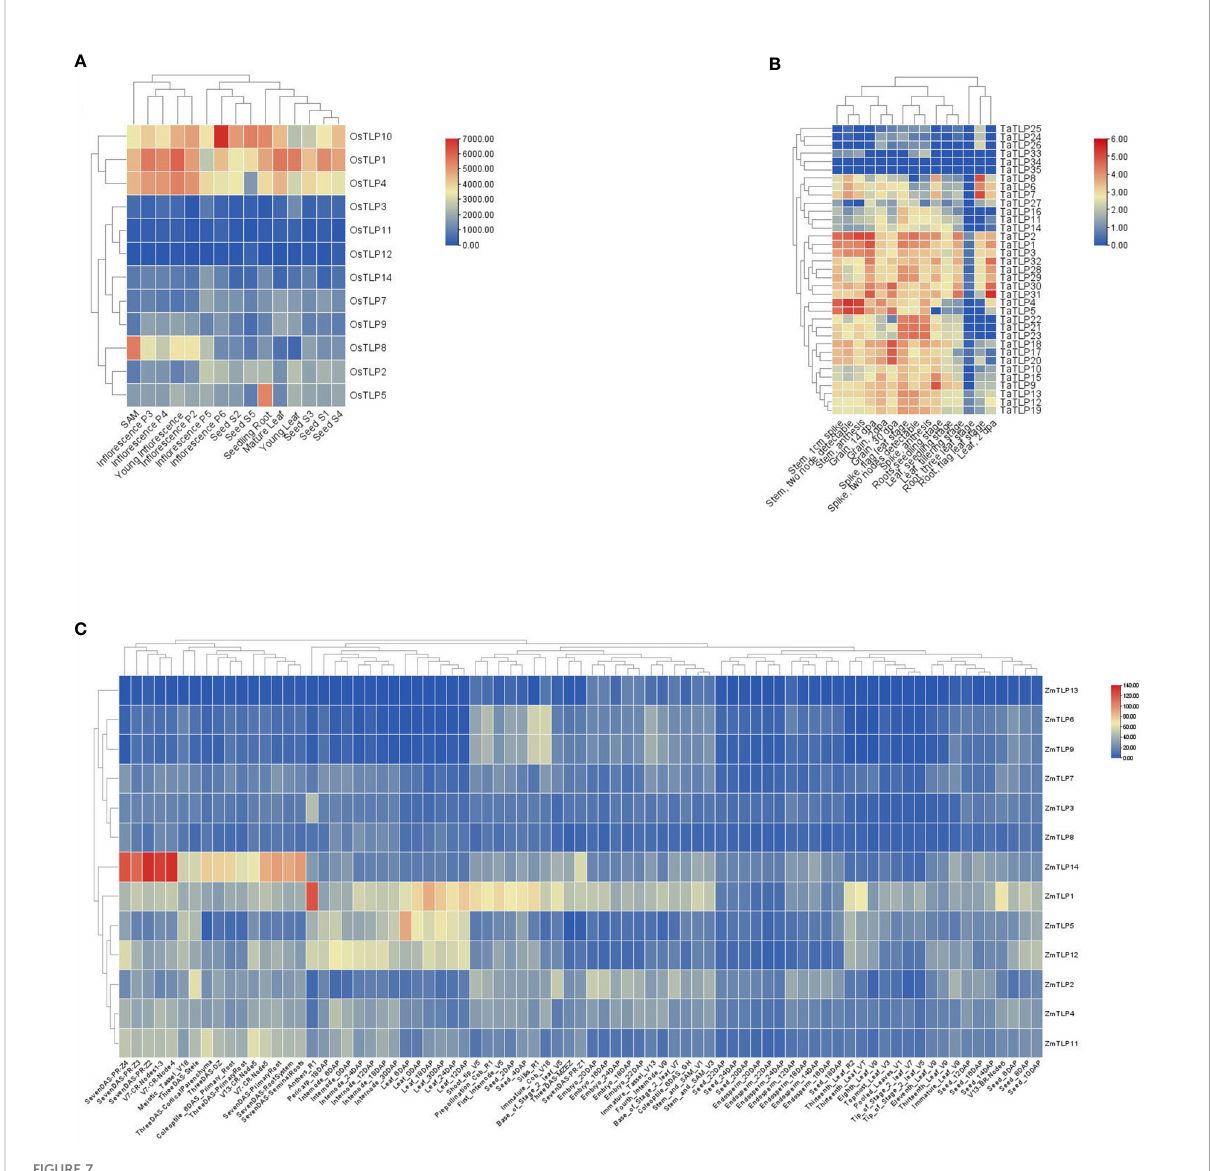
FIGURE 7 Expression pro fi les of TLP in three cereal crops. O.sativa (A) , T.aestivum (B) , and Z.mays (C) . The red/blue indicated high/low level of TLP transcript